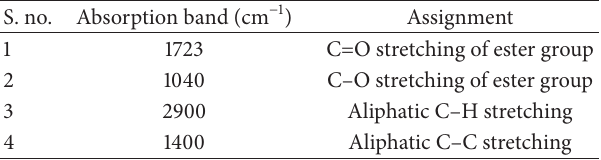
Table 1: IR spectral data of copolyester PIFB in cm − 1 .